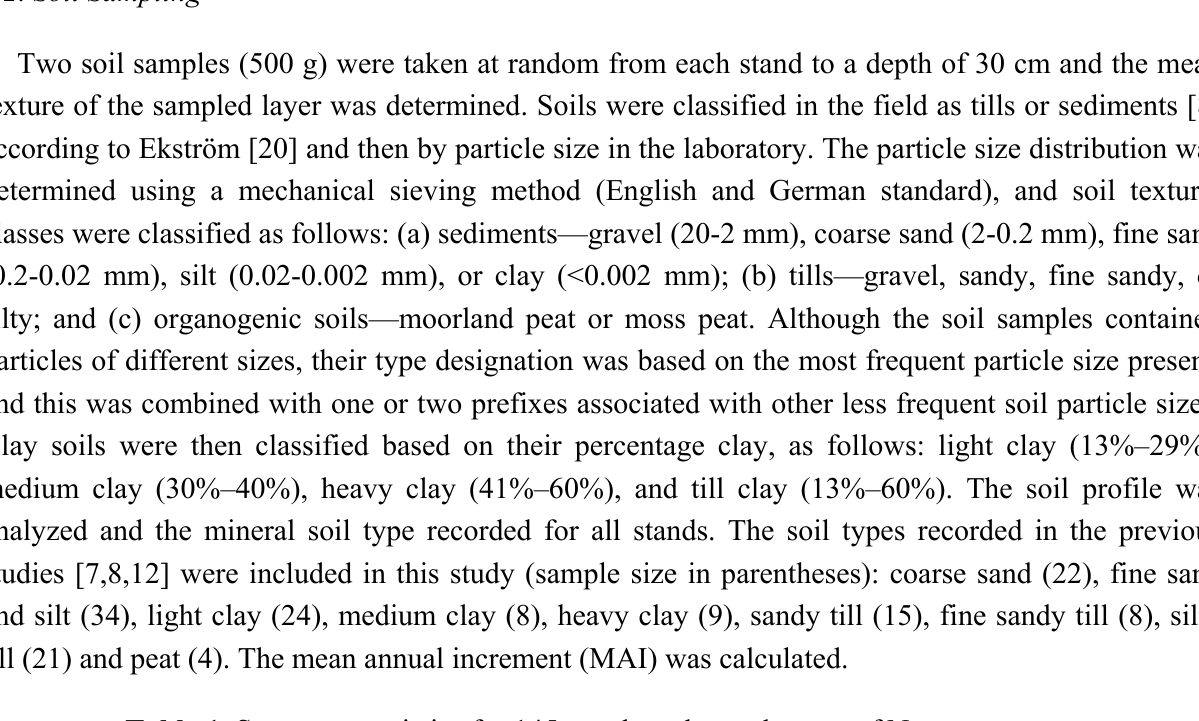
Table 1. Summary statistics for 145 stands and sample trees of Norway